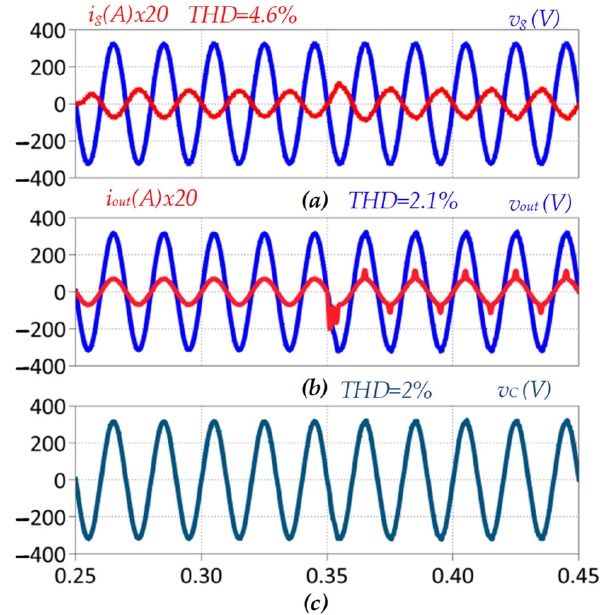
Figure 7. Voltage and current shape at the main grid ( a ), output ( b ), and capacitor of the filter ( c ) with k out = 0, k c = 1 .